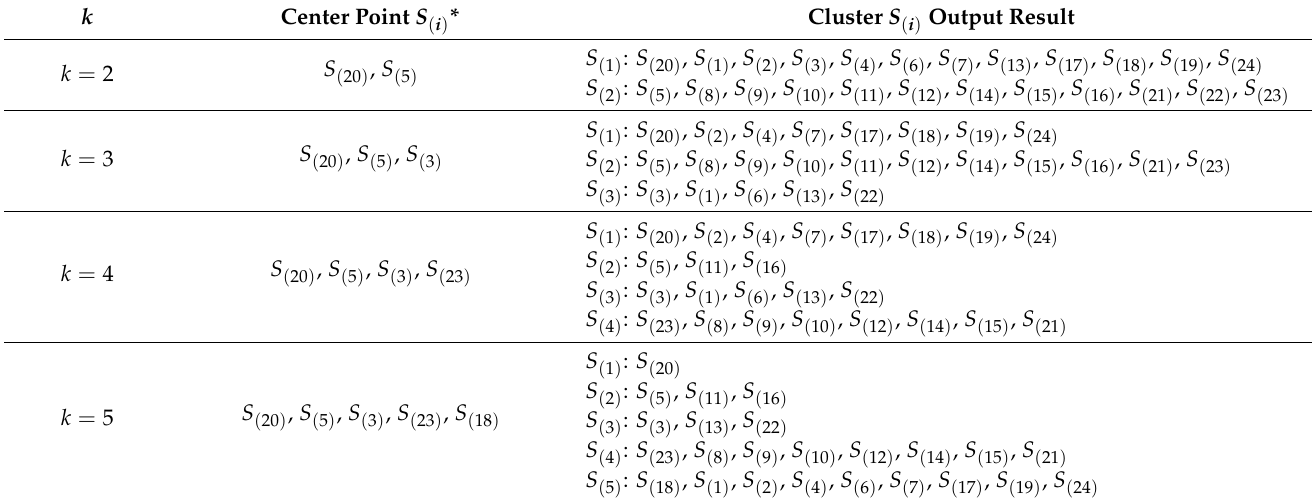
Table 3. Each cluster’s output result under different cluster quantity conditions.